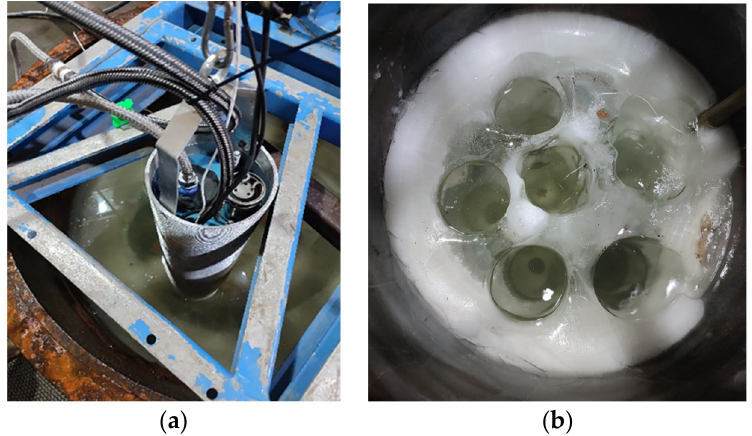
Figure 7. Test overview: ( a ) drill before drilling begins; ( b ) the ice well after tests. 3.1. Effect of the Orifice Number and the Forward/Backward Orifice Axial Angle α on the ROP